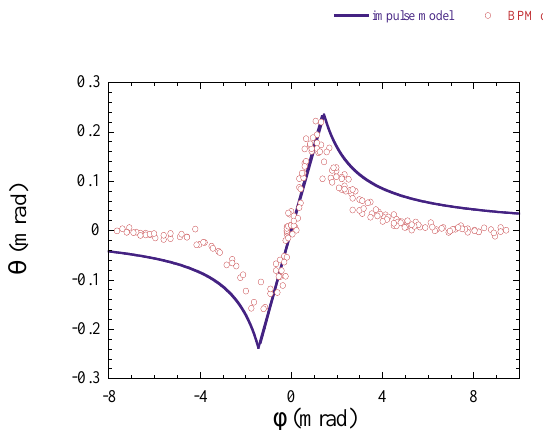
FIG. 3. (Color) Experimentally measured electron beam deflec- tion u as a function of angle between laser and e beam (i.e., angle of incidence f ). The solid curve is the impulse model from Eqs. (2) and (3) with a (cid:1) 1.4 for the bunch length and plasma density corresponding to this run (0.7 mm and 1 3 10 14 cm 2 3 , respectively). Since the beam deflection measured by the beam position monitor is a weighted average over the entire beam, it is less than one would obtain for the peak de- flection of the tail portion of the beam. To compare to the data, the impulse model has been scaled by an overall factor (0.17). Note that the critical angle for total internal reflection (the cusp in the figure) is independent of the choice of scaling factor. Figure 3 is a plot of beam deflection (cid:2) u (cid:3) measured with the beam position monitor versus angle between the laser and the beam (cid:2) f (cid:3) . The solid curve is the prediction from the impulse model. For incident angles f less than 1.3 mrad, the beam appears to be internally reflected in agreement with Eqs. (2) and